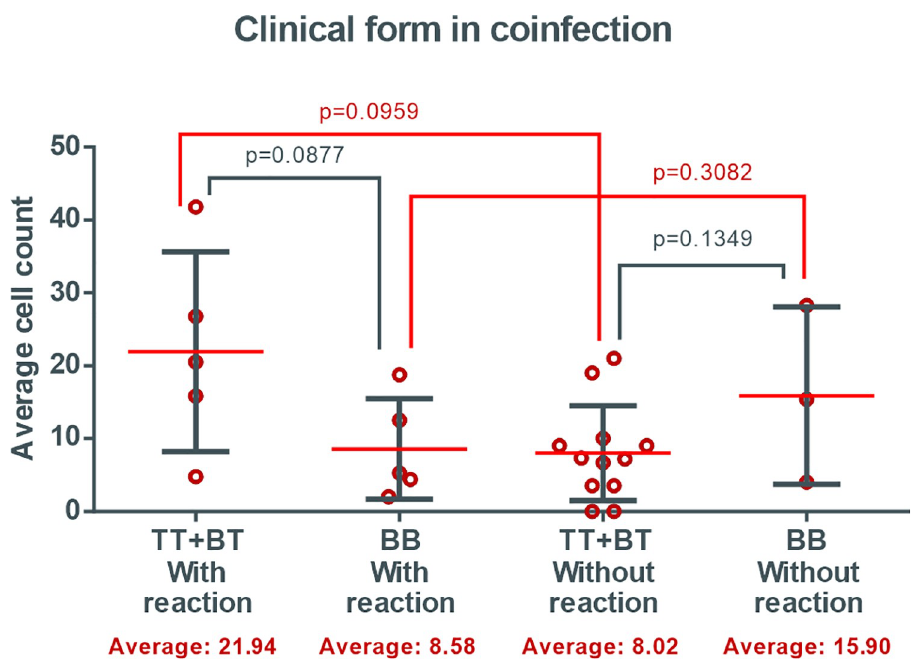
Fig 7. Density of cells expressing FOXP3 in patients with leprosy co-infected with HIV, according to clinical form � and presence of reverse reaction. � Clinical forms: borderline borderline (BB), borderline tuberculoid (BT) and tuberculoid